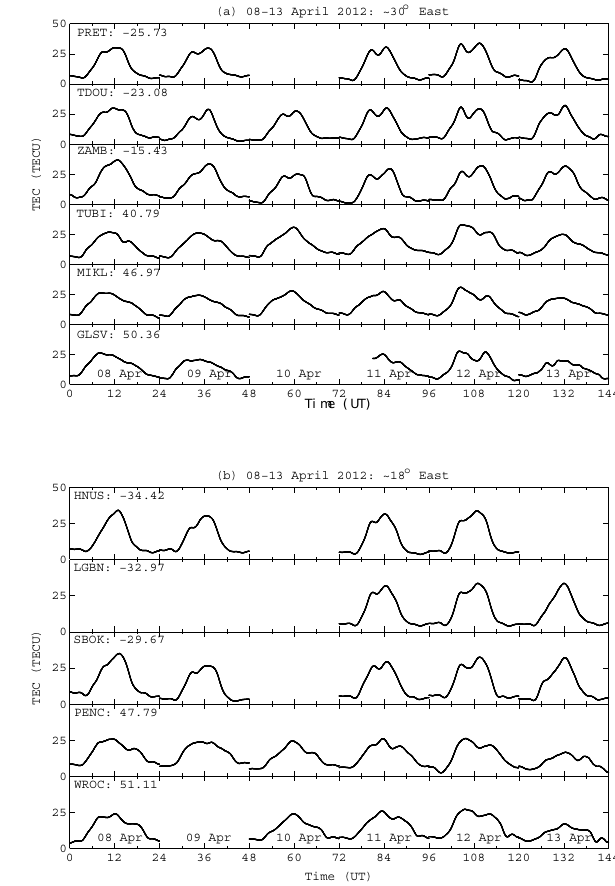
Figure 3. Twin-peak structures observed on 11–13 April 2012 from Northern and Southern Hemisphere GPS stations; station’s code and geographic latitudes also included (negative latitudes indicate south, and positive latitudes indicate